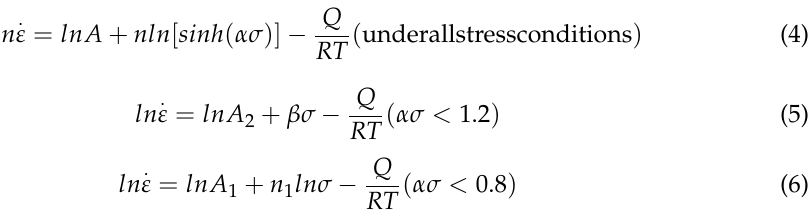
Figure 3. Linear fitting under true strain of 0.5: ( a ) ln 𝜀̇ −σ; ( b ) ln 𝜀̇ −lnσ; ( c ) ln 𝜀̇ − ln[sin h( ασ )]; ( d ) ln[sin h( ασ )] − 1000/T.